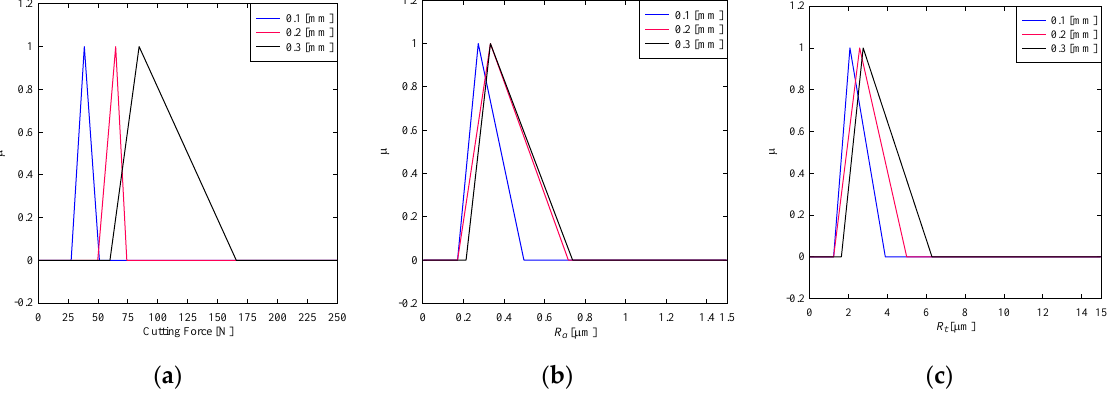
Figure 6. Effect of depth of cut on ( a ) cutting force ( b ) R a ( c ) R t . Lastly, consider the effects of feed rate, f , (mm/rev), on the cutting force and surface roughness, as shown in Figure 7. The feed rates up to 0.075 mm/rev can minimize the cutting force, and the feed rate of 0.05 mm/rev exhibits the lowest cutting force, as shown in Figure 7a. The uncertainty increases when the feed rate is 0.1 mm/rev. Thus, the feed rate of 0.05 mm/rev is recommended for minimizing cutting force. A similar argument holds for surface roughness. As seen in Figure 7b, minimizing the feed rate minimizes the surface roughness in terms of R a . The same argument is true for R t , as seen in Figure 7c. For quantitative analysis, the expected values of the cutting force and surface roughness are calculated using the centroid method. The results are shown as follows, which reconfirm the abovementioned qualitative analysis. The expected values of cutting force are 53.53 N, 60.8 N, and 91.467 N for feed rates 0.05 mm/rev, 0.075 mm/rev, and 0.1 mm/rev, respectively. The expected values of surface roughness in terms of R a are 0.242 µ m, 0.323 µ m, and 0.496 µ m for feed rates 0.05 mm/rev, 0.075 mm/rev, and 0.1 mm/rev, respectively. The expected values of surface roughness in terms of R t are 2.51 µ m, 3.31 µ m, and 3.67 µ m for feed rates 0.05 mm/rev, 0.075 mm/rev, and 0.1 mm/rev, respectively.